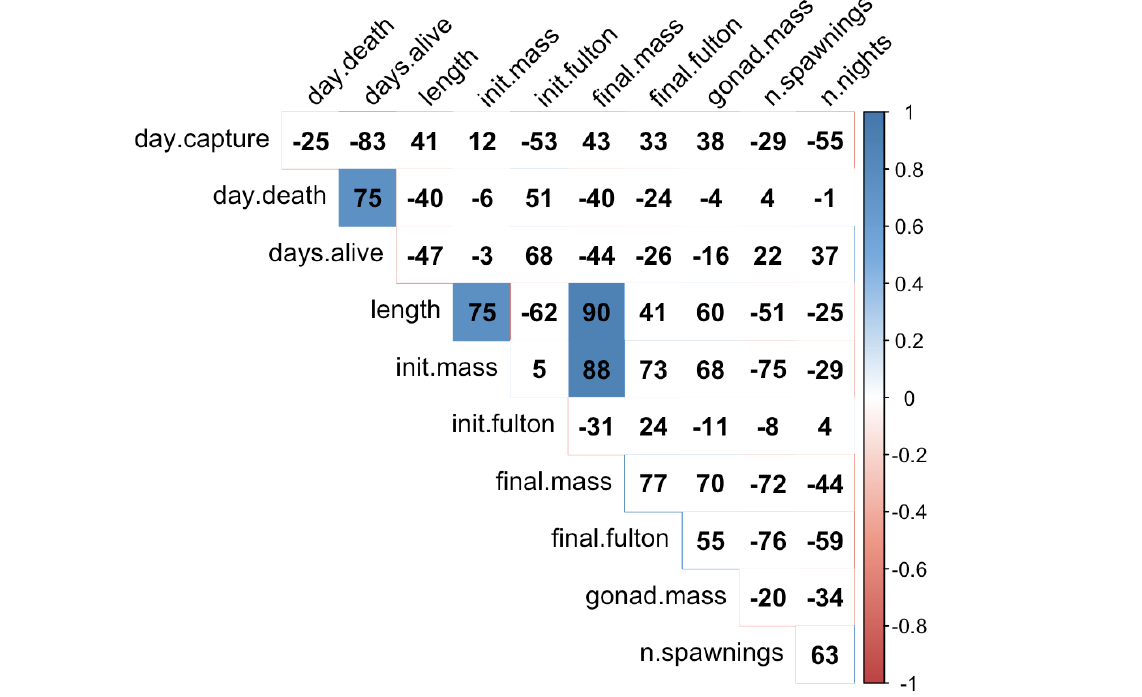
Figure 2. Spearman coefficient of correlation (expressed as percentage) between biometric and reproductive variables of female Allis shad. In order, day of capture, day of death, number of days between capture and death, body length, initial mass, initial Fulton coefficient of condition, final mass, final Fulton coefficient of condition, final gonad mass, number of spawning acts, number of nights with at least one spawning